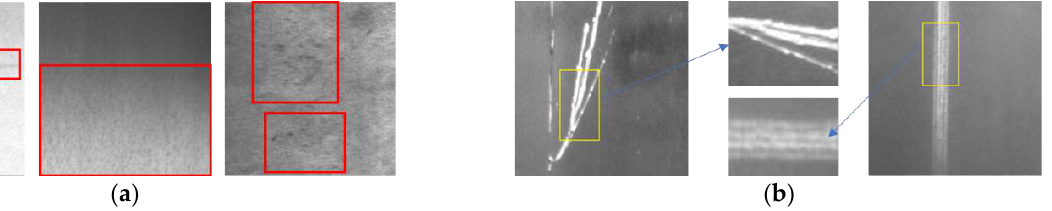
Figure 1. Challenges of defect inspection. ( a ) shows the low contrast between defects and background in the image. ( b ) shows the intra-class difference.